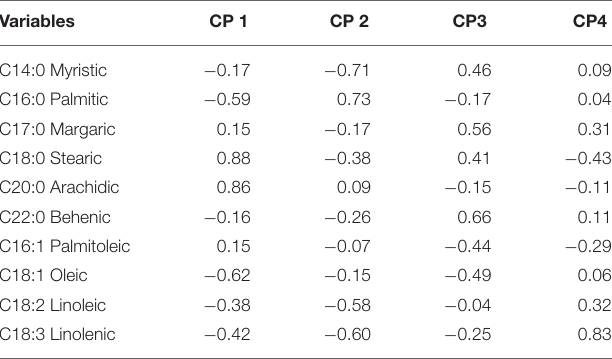
TABLE 5 | Correlation between originally measured variables and selected components.